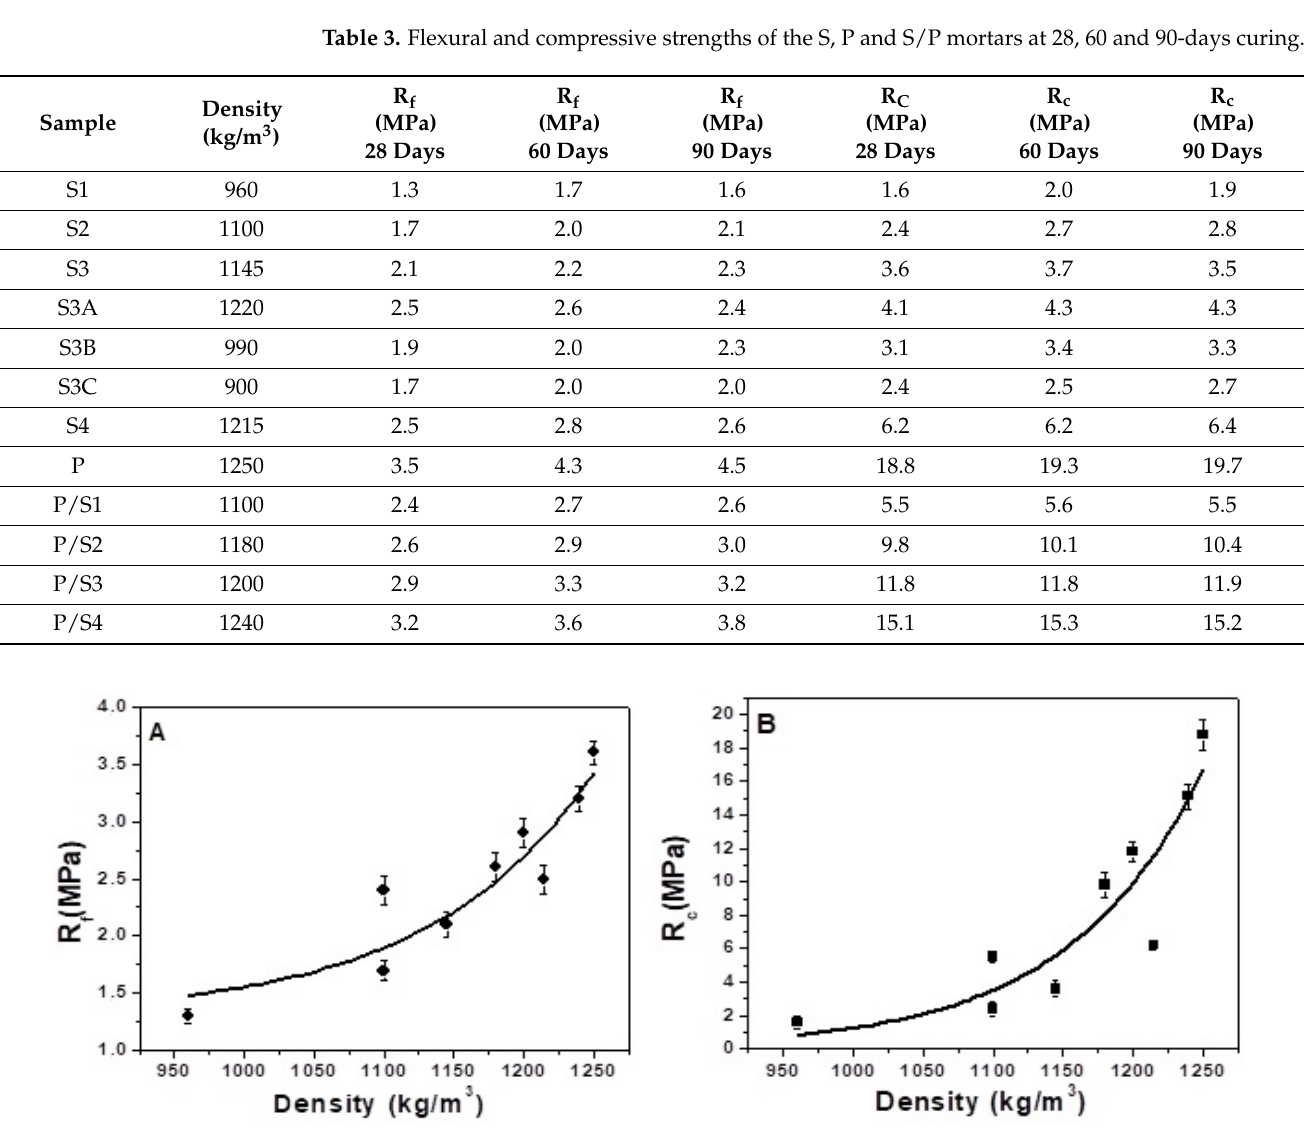
Figure 8. ( A ) Flexural and ( B ) compressive strengths of the S, P and S/P mortars with the same volume of aggregate (400 mL) as a function of the composite density (28 days ageing).